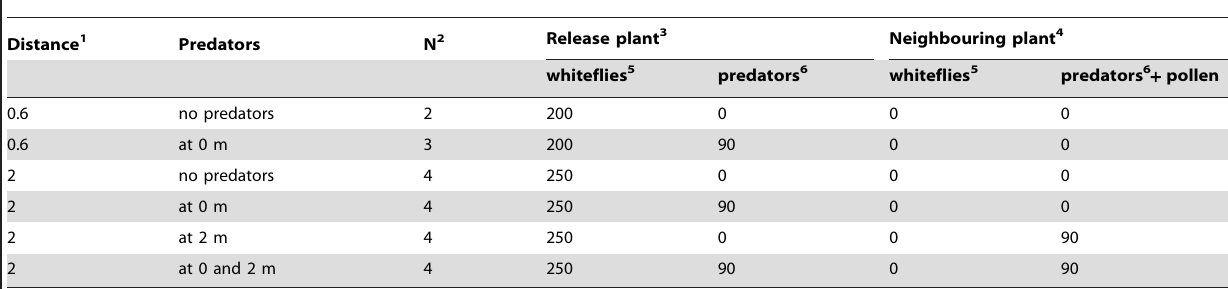
Table 1. Summary of the release schedule of the